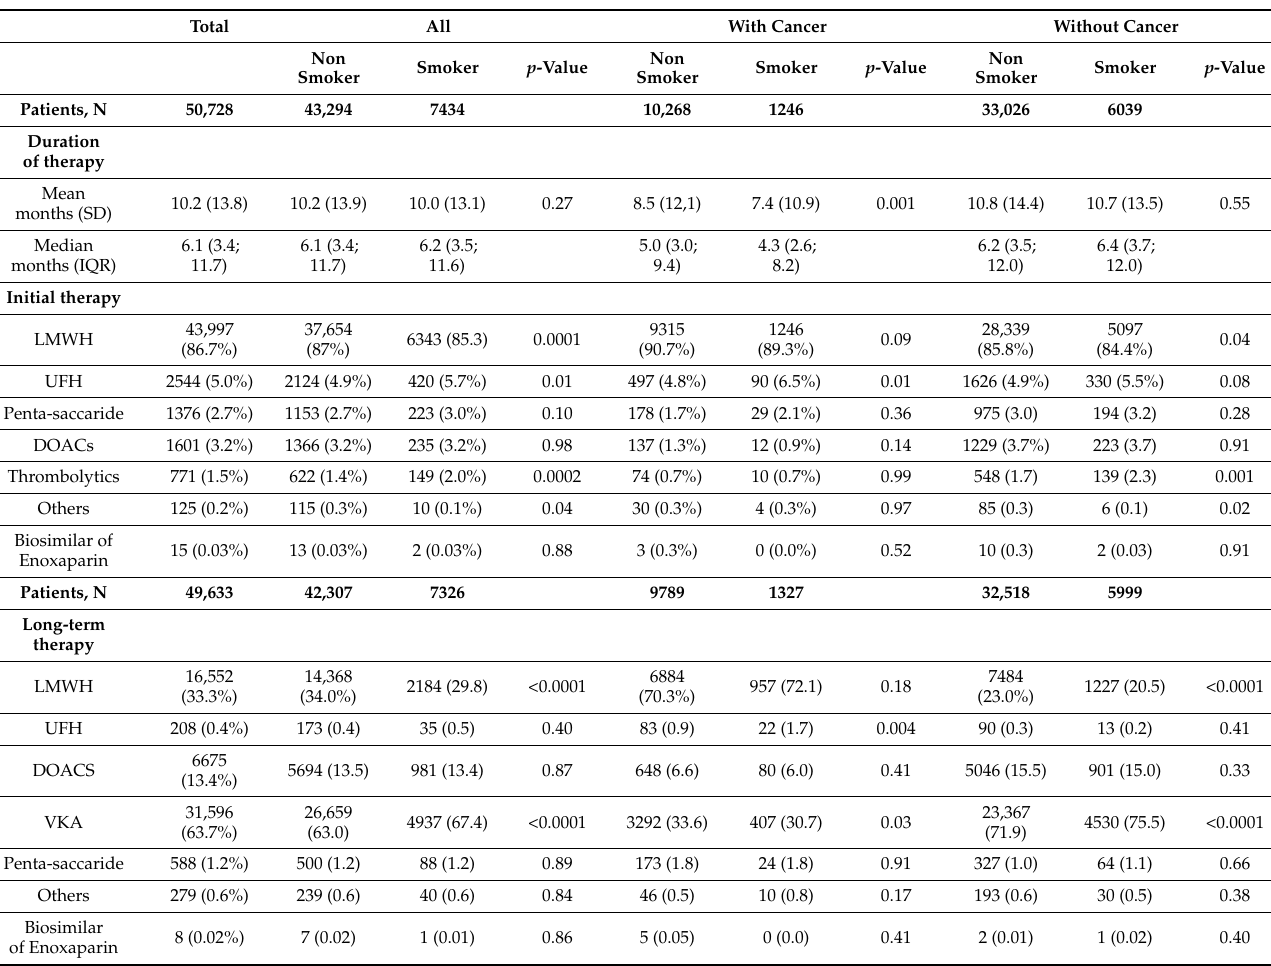
Table 2. Treatment strategies according to smoking behavior at baseline and the presence or absence of cancer.